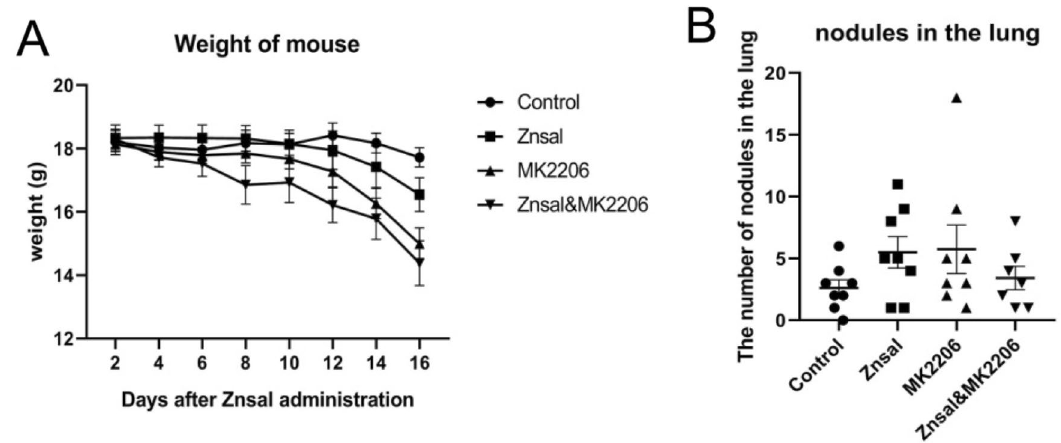
Figure 5. Effect of Zn{[CH 3 ) 3 C] 2 Sal} 22− on lung metastasis in vivo . Lung tumorigenesis was established by injecting 4T1 cells through the tail vein of BALB/c mice. ( A ) Changes in mouse body weight after 16 days of treatment with Zn{[CH 3 ) 3 C] 2 Sal} 22− or MK2206 alone or in combination. ( B ) Number of tumor nodules in the mouse lung after 16 days of Zn{[CH 3 ) 3 C] 2 Sal} 2 2− or MK2206 treatment alone or in